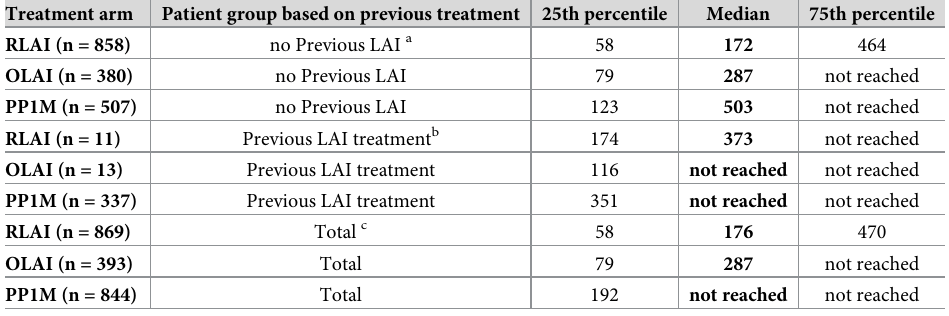
Table 5. Estimates of median time and the lower and upper quartiles of days elapsed to treatment discontinua- tions in different treatment groups as a function of prior treatment. Treatment